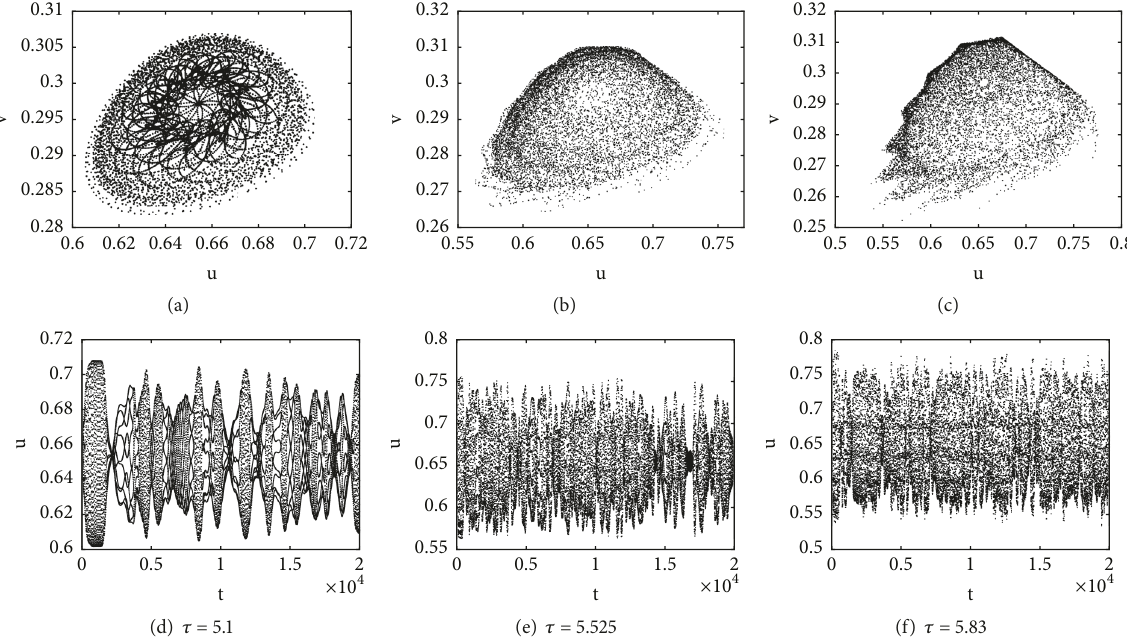
Figure6:Phaseportraitsandwavediagramscorrespondingtothechangeofstatevariablesinlattice(100,100)ofFigures3–5withtheincrease of